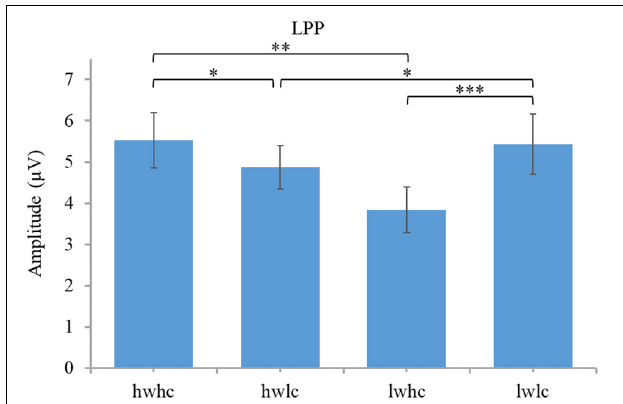
FIGURE 11 | Descriptive statistics and contrasts for the LPP (hw, high warmth; lw, low warmth; hc, high competence; lc, low competence;